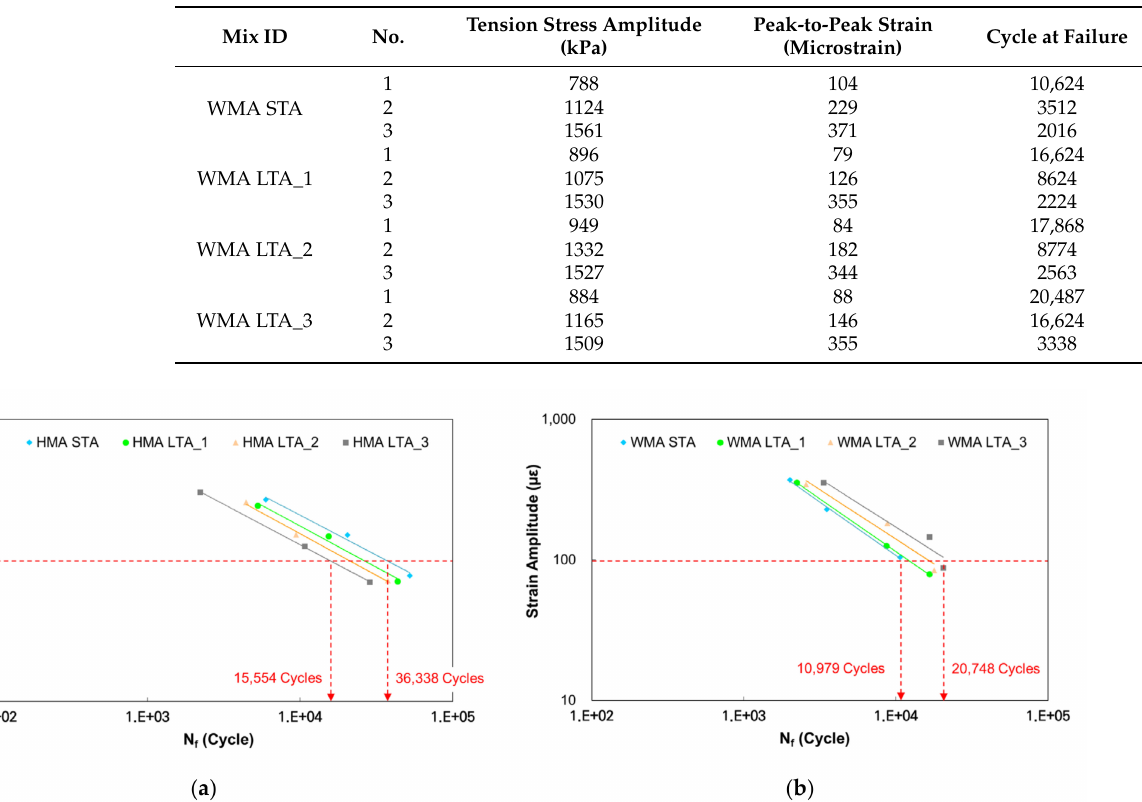
Figure 14. Allowable fatigue cracking cycles before moisture damage for each stage of aging: ( a ) HMA and ( b ) WMA.